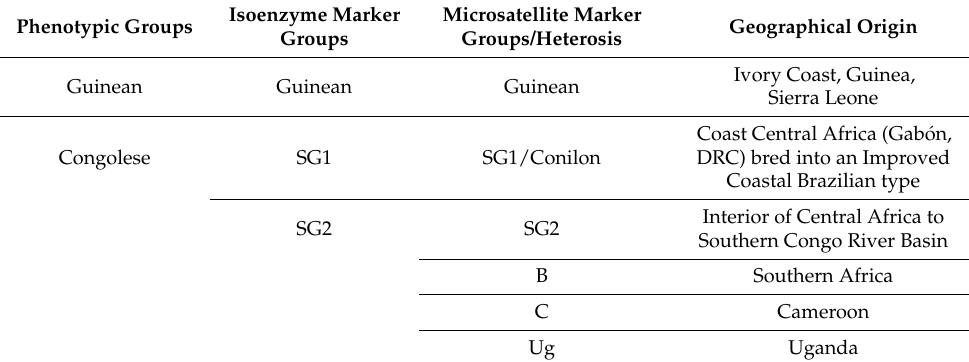
Table 1. Germplasm of interest to the Colombian breeding program and